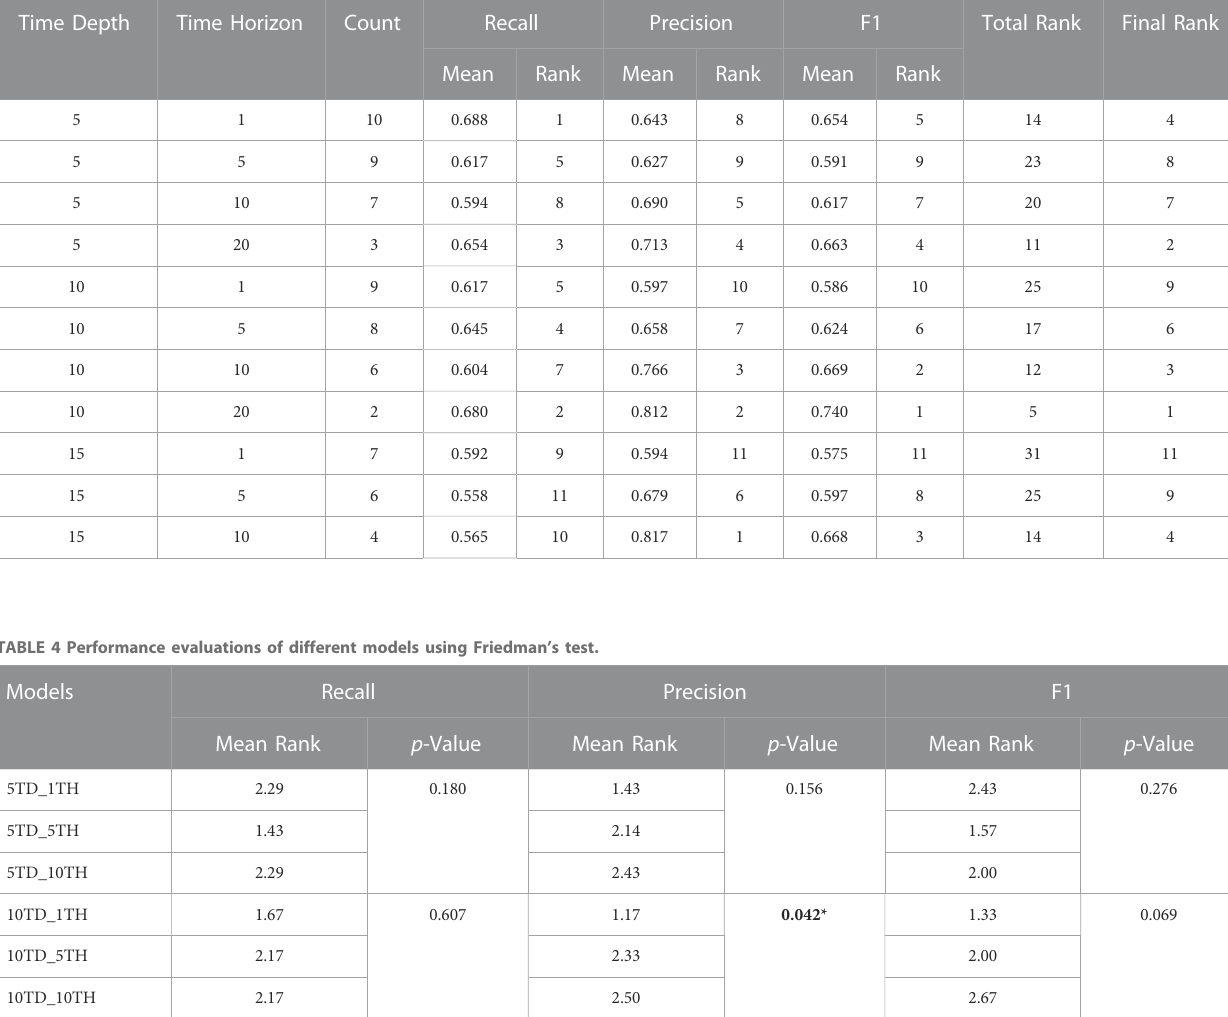
TABLE 3 Ranks of different combinations of time depth and time horizon evaluation for total land loss.